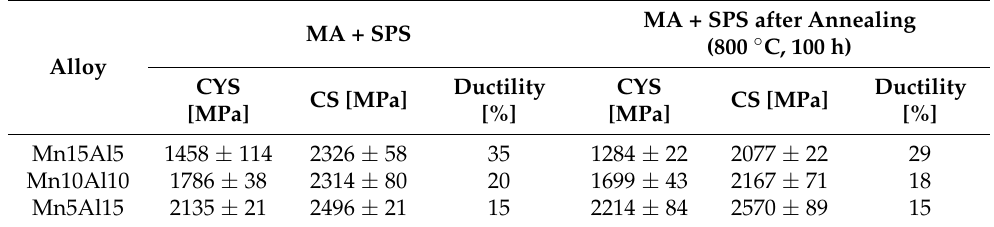
Figure 10. Compressive stress–strain test for alloys at room temperature: ( a ) MA + SPS; ( b ) MA + SPS after annealing (800 °C, 100 h). Table 5. Summary of mechanical properties of the MA + SPS compacts in their as-compacted and annealed state (800 °C, 100 h). (± values represent confidence intervals).